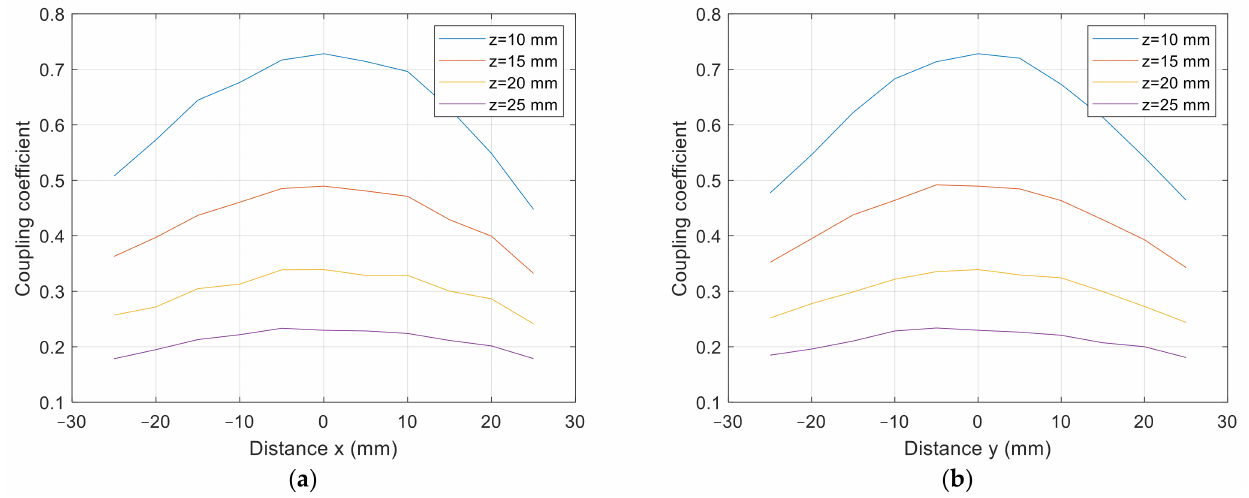
Figure 12. x - y coupling coefficient measurement of planar square coils. ( a ) At y = 0 mm, at ( b ) x = 0